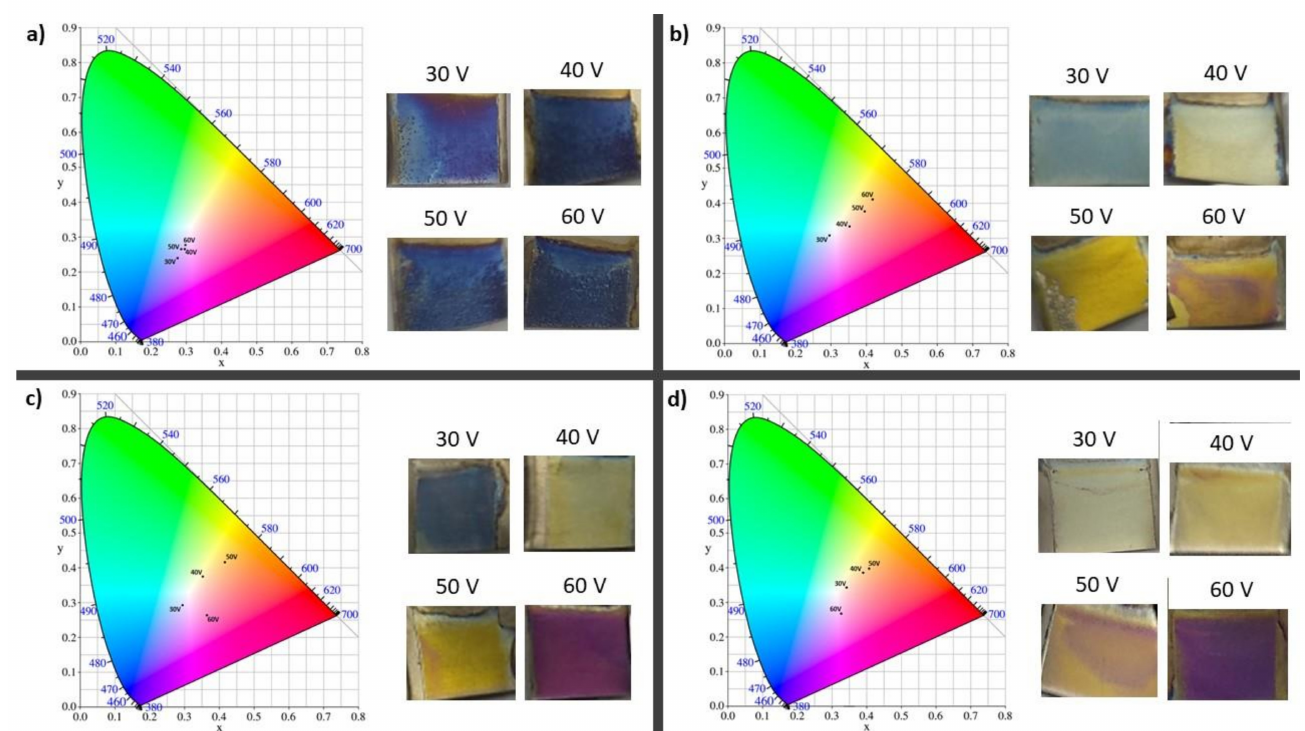
Figure 6. The calculated values of the CIE coordinates represented on the CIE diagram and the macroscopic view of titanium anodic oxide samples fabricated in electrolyte with ( a ) 2 vol% of H 2 O; ( b ) 3.5 vol% of H 2 O; ( c ) 5 vol% of H 2 O; and ( d ) 10 vol% of H 2